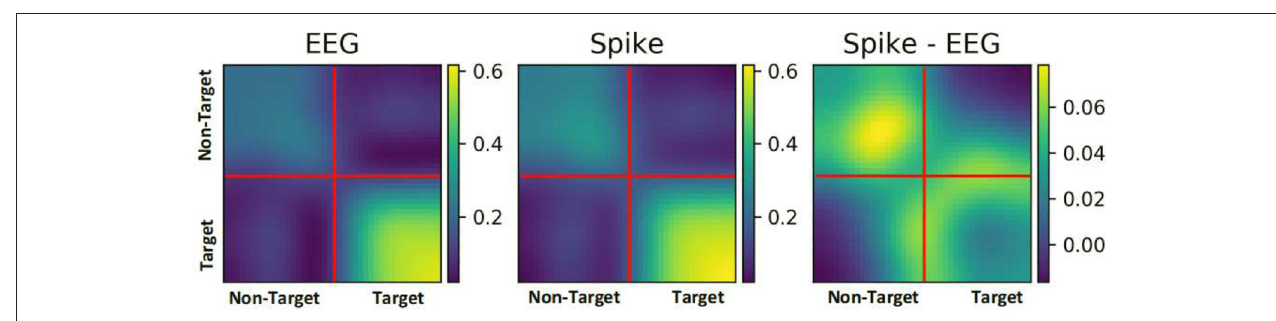
FIGURE 6 | Pearson correlation among all the samples in an ERN dataset for both EEG signal and its spike-representation (from LIF). Spike representation forged a higher correlation among the samples of a given class.